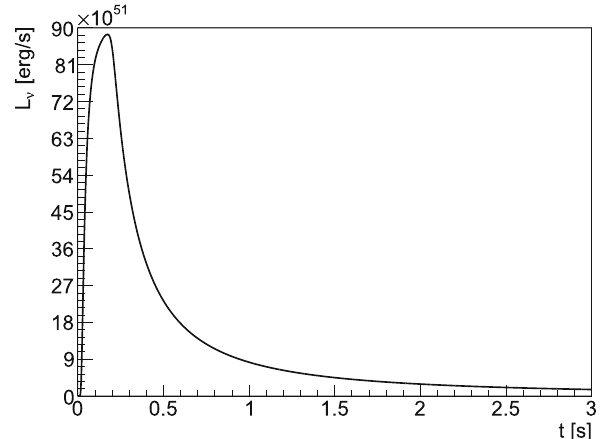
Fig. 1 Time evolution of the neutrino luminosity in the considered simplified model